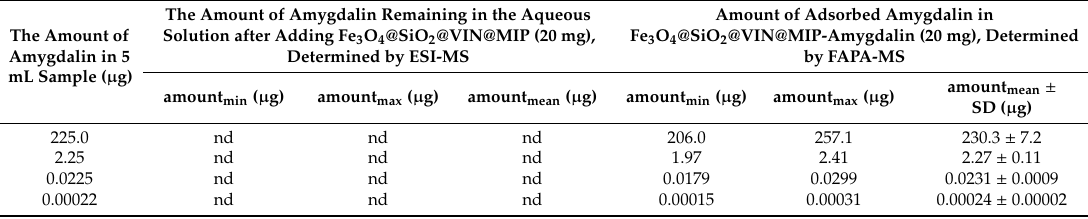
Figure 17. The concentration of amygdalin over time in solution after addition of